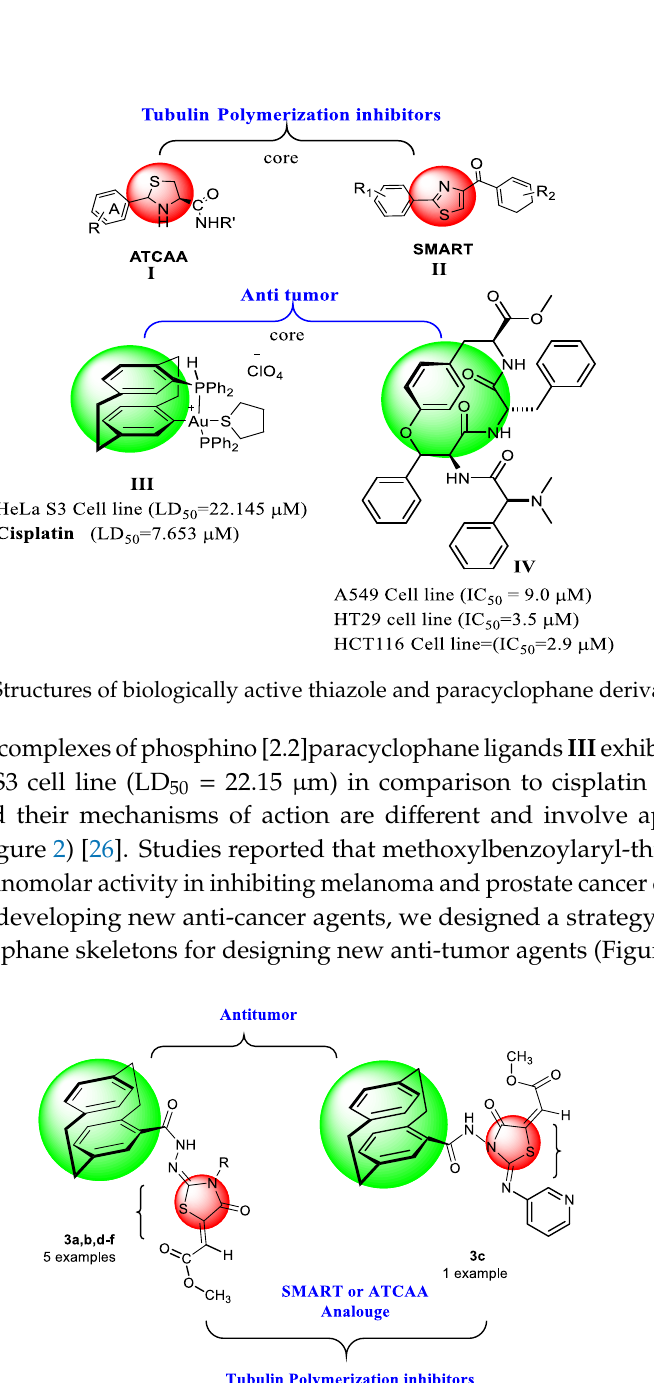
Figure 3. Design of the target compounds 3a – f.